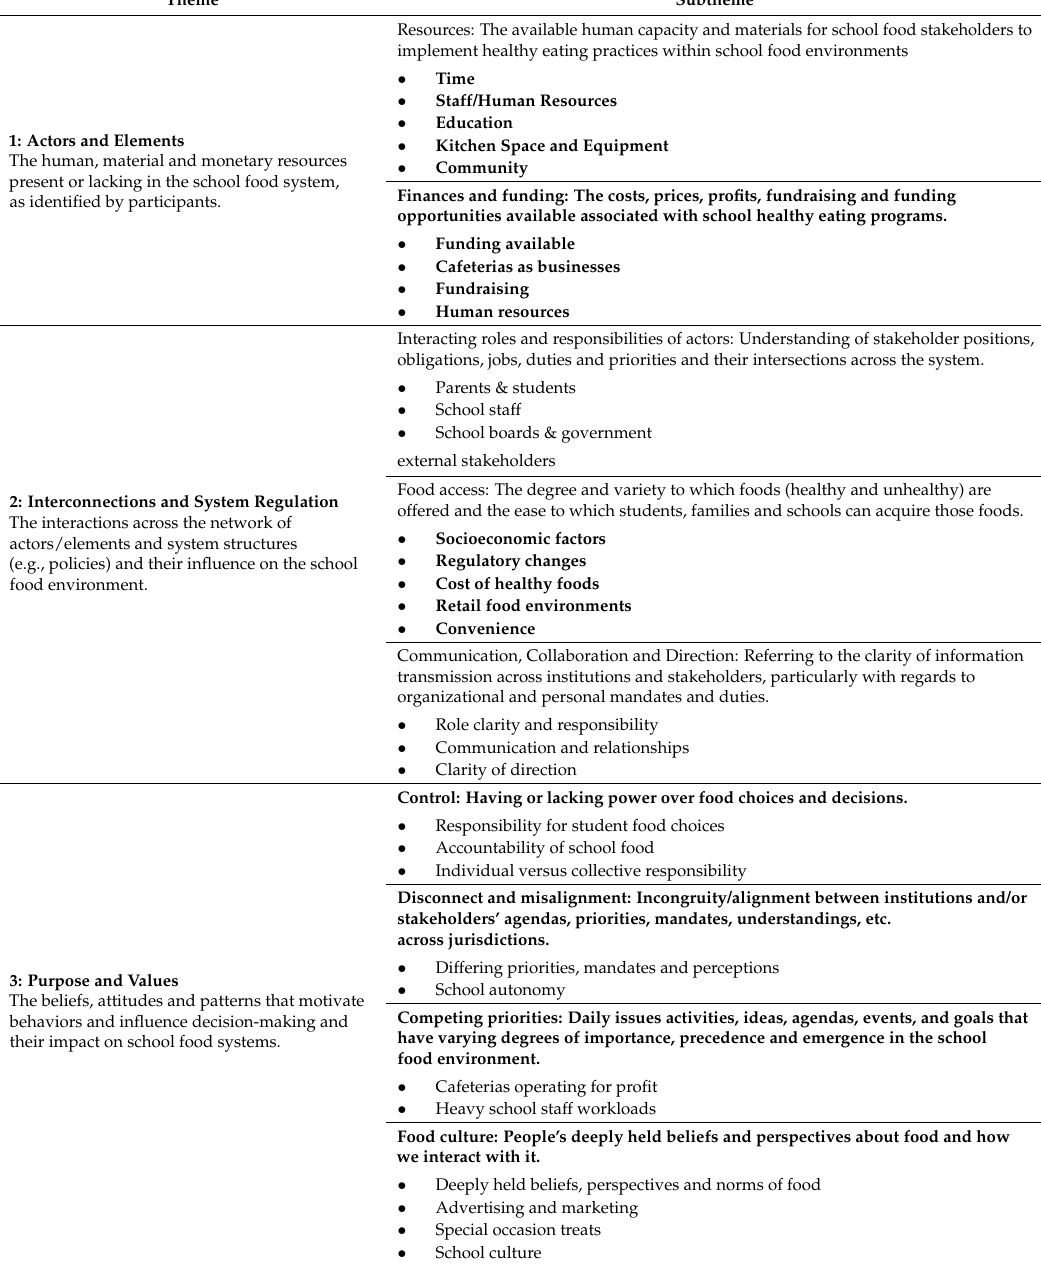
Table 2. Descriptions of themes and subthemes identified within the school food system. Theme